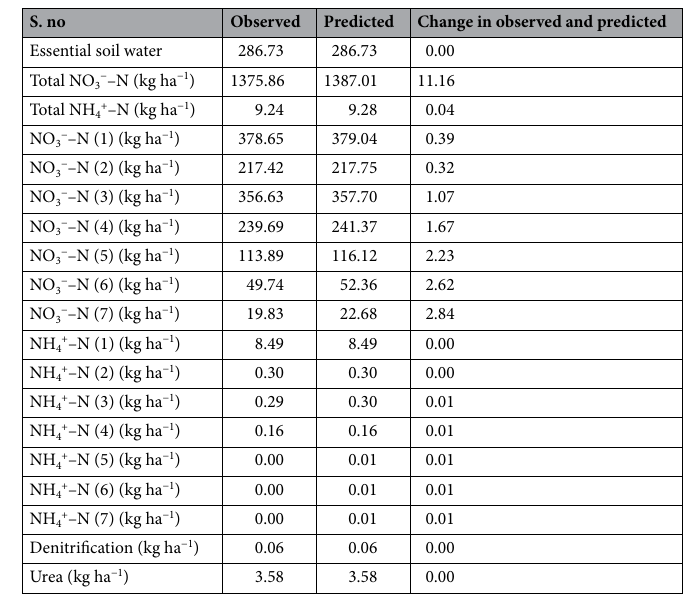
Table 3. 20-years average soil NO 3 − –N and NH 4 + –N, essential soil water and urea and denitrification losses in the soil layer from 1 to 7 in observed and predicted